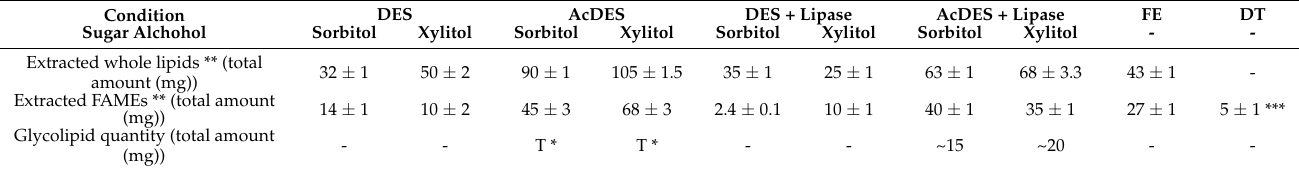
Table 2. Amounts of extracted whole lipids, FAMEs, and glycolipids per 10 mL of